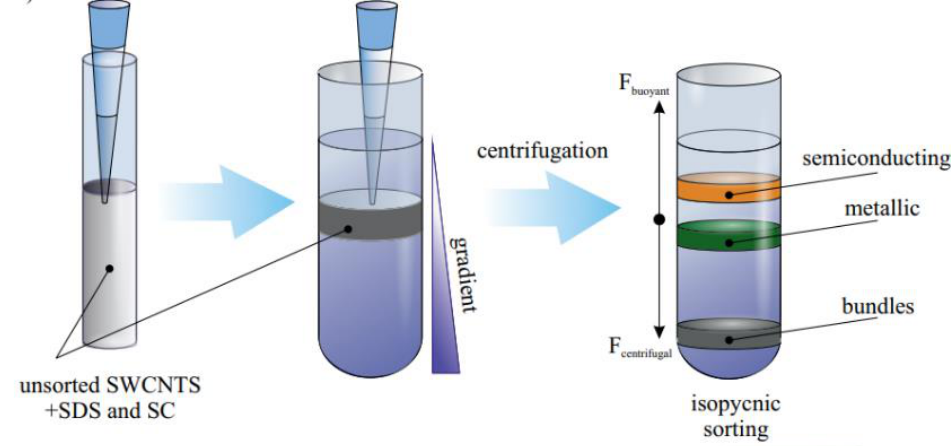
Figure 14. Schematics for the separation of SWCNTs using the density gradient ultracentrifugation technique. SWCNTs that have not been sorted are put into a centrifuge tube that has a gradient of mass density. During ultracentrifugation, due to a competition between the applied centrifugal force and the resultant opposing buoyant force, surfactant-wrapped SWCNTs migrate through the gradient until reaching the isopycnic point (equilibrium), where forces are balanced. The local gradient of the density gradient and the density of SWCNT are equivalent at this site.